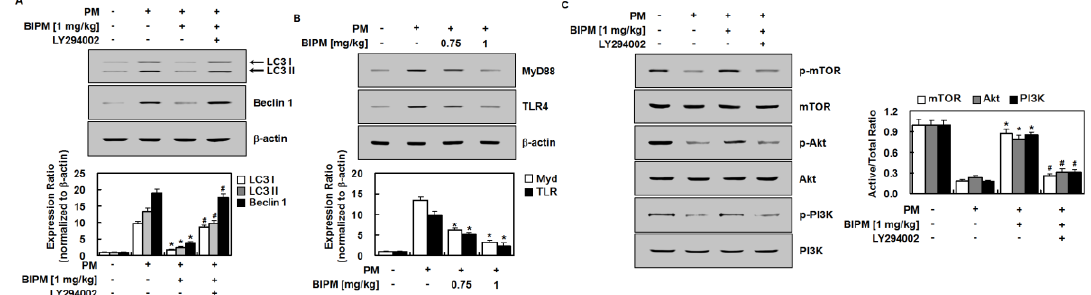
Figure 6. E ff ects of BIPM on PM-induced signaling pathways. BIPM groups were injected intravenously Figure 6. Effects of BIPM on PM-induced signaling pathways. BIPM groups were injected 30 min after being intratracheally challenged with PM 2.5 (10 mg / kg in 50 µ L of saline). The mice then intravenously 30 min after being intratracheally challenged with PM 2.5 (10 mg/kg in 50  L of saline). were sacrificed 24 h post-PM-injection, and the lung tissue was harvested. Representative examples of The mice then were sacrificed 24 h post-PM-injection, and the lung tissue was harvested. Western blot analysis demonstrate the expression levels of ( A ) LC3 and Beclin 1; ( B ) TLR4 and MyD88; Representative examples of Western blot analysis demonstrate the expression levels of ( A ) LC3 and and ( C ) p-mTOR, mTOR, p-Akt, Akt, p-PI3K and PI3K. Representative images from each group are Beclin 1; ( B ) TLR4 and MyD88; and ( C ) p‑mTOR, mTOR, p‑Akt, Akt, p‑PI3K and PI3K. Representative shown ( n = 3). The graphs show the densitometric intensities of each protein, normalized to β -actin images from each group are shown ( n = 3). The graphs show the densitometric intensities of each ( A , B ) or total form ( C ). For the blots, n = 3. + : treated; − : protein, normalized to  -actin ( A , B ) or total form ( C ). For the blots, n = 3. +: treated; -: untreated.